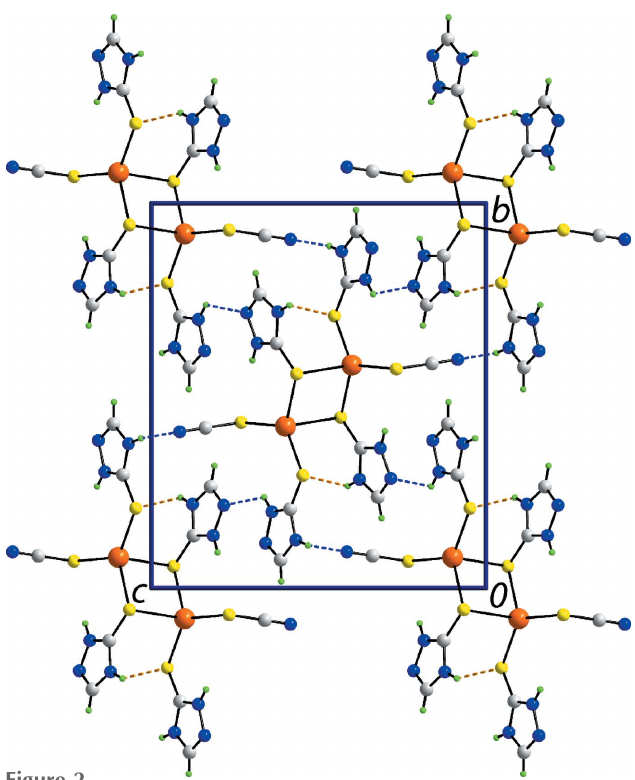
Figure 2 A view of the unit-cell contents of (I) in projection down the a axis, with